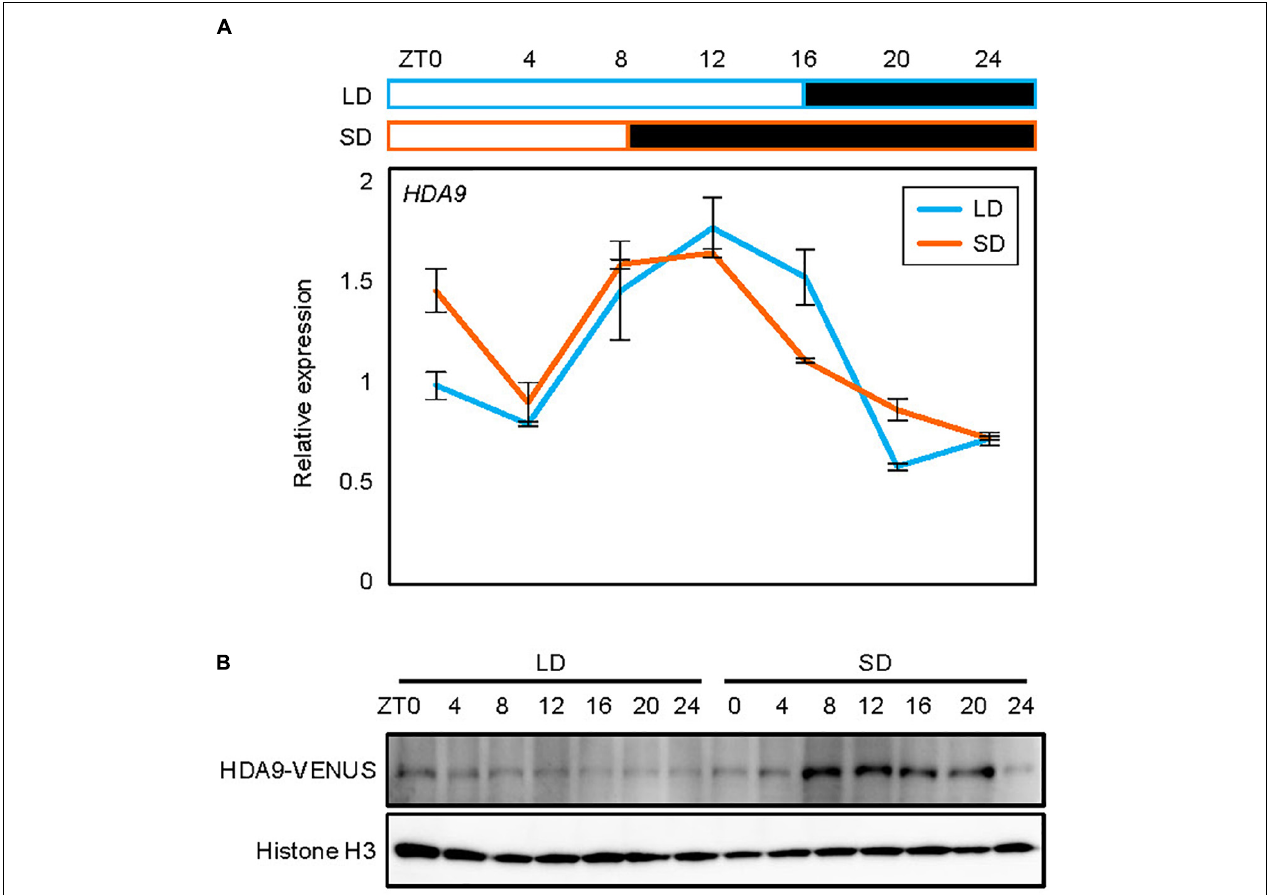
FIGURE 2 | Accumulation of HDA9 protein in short days (SDs) relative to that in long days (LDs). Seedlings grown under LD and SD conditions for 7 days were harvested at 4 h intervals within a 24 h period. (A) Expression analysis of HDA9 . Transcript levels of HDA9 were analyzed by quantitative real-time reverse transcription PCR (RT-qPCR) and normalized relative to that of eIF4A . Error bars indicate the standard error of mean (SEM). White and black boxes indicate subjective day and night, respectively. (B) Analysis of nuclear HDA9 protein level. The HDA9-VENUS fusion protein in pHDA9:HDA9-VENUS/hda9-1 plants were immunologically detected by Western blot analysis. Histone H3 accumulation was used as a loading